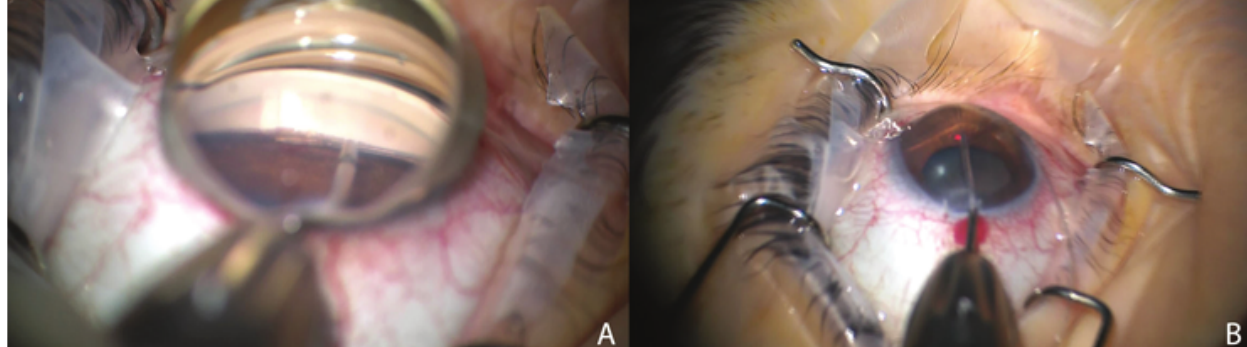
Figure 3. (A) Intraoperative gonioprism view demonstrating insertion of microcatheter into Schlemm’s canal using microsurgical forceps via a goniotomy at the nasal angle. (B) The microcatheter has a red light at its proximal end, which is visible through the sclera as the microcatheter passes through Schlemm’s canal. Once it has been passed for 360 degrees, the proximal end is held in place while the distal end is externalized to create a 360-degree